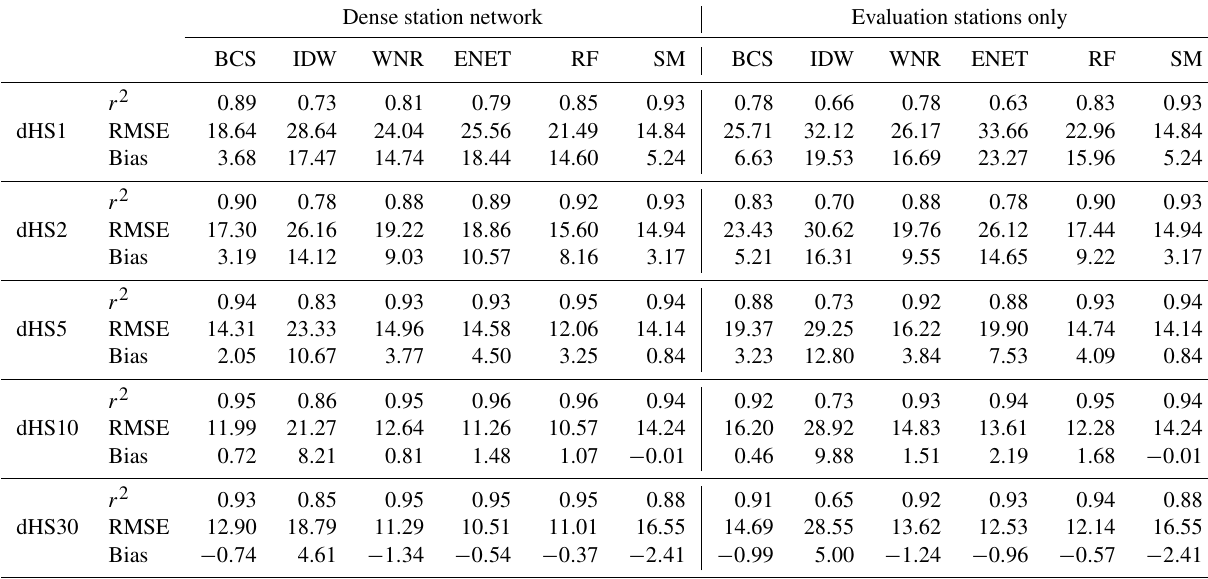
Table A1. Bias, RMSE and coefficient of determination ( r 2 ) for the 1cm (dHS1), 2cm (dHS2), 5cm (dHS5), 10cm (dHS10) and 30cm (dHS30) thresholds for the number of snow days reconstructed with the different methods in the dense and sparse station networks. Dense station network Evaluation stations